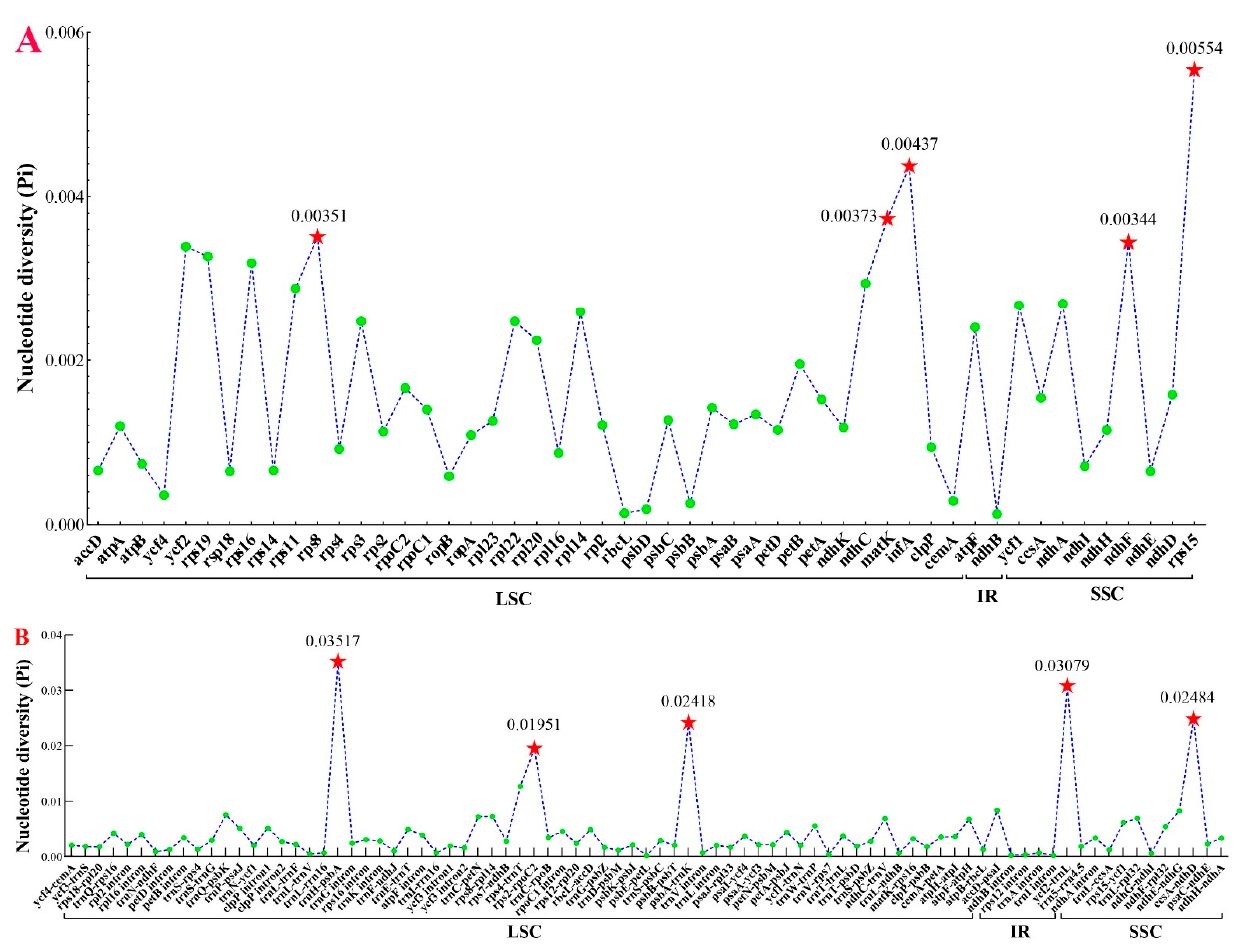
Figure 9. Comparative analysis of the nucleotide diversity (Pi) values among the ten plastomes. ( A ) protein-coding genes; ( B ) non-coding and intron regions. ( A ) protein-coding genes; ( B ) non-coding and intron